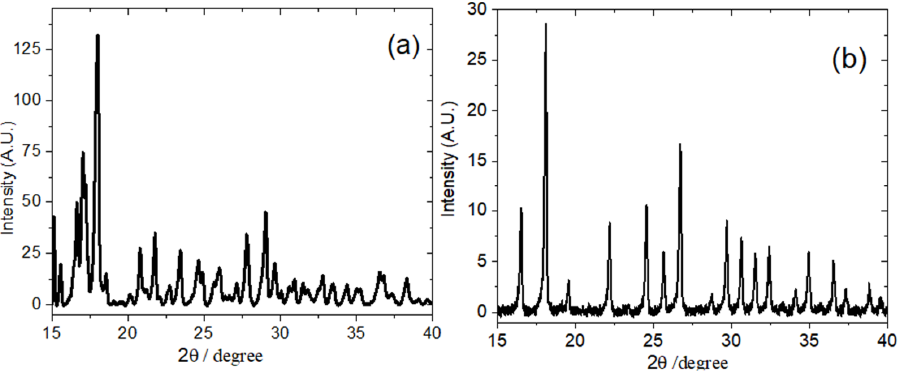
Figure 1. XRD pattern of ( a ) ZIF ‐ L/ ‐ 8 (jn ‐ 01), and ( b ) ZIF ‐ 67 ‐ 1 (jn ‐ 04) powder samples. The ZIF ‐ 8(ZIF ‐ L) sample gave a match with the COD 7222297 database card, which is an intermediate phase corresponding to the ZIF ‐ L morphology with the main peaks in ‐